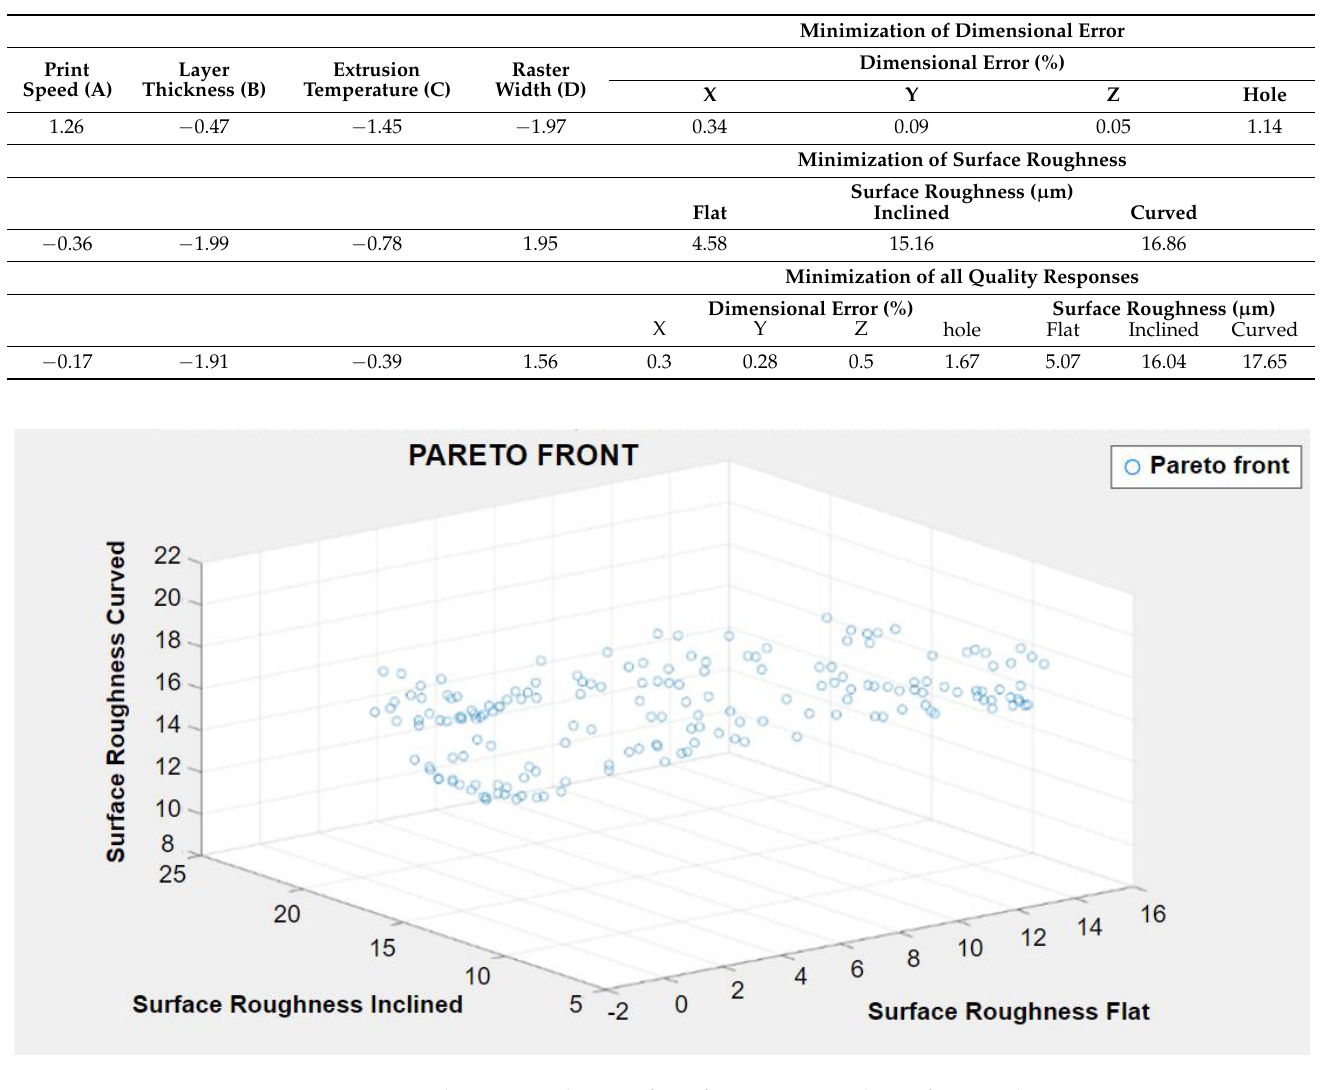
Table 7. Shifted parameter settings for optimizing dimensional error and surface